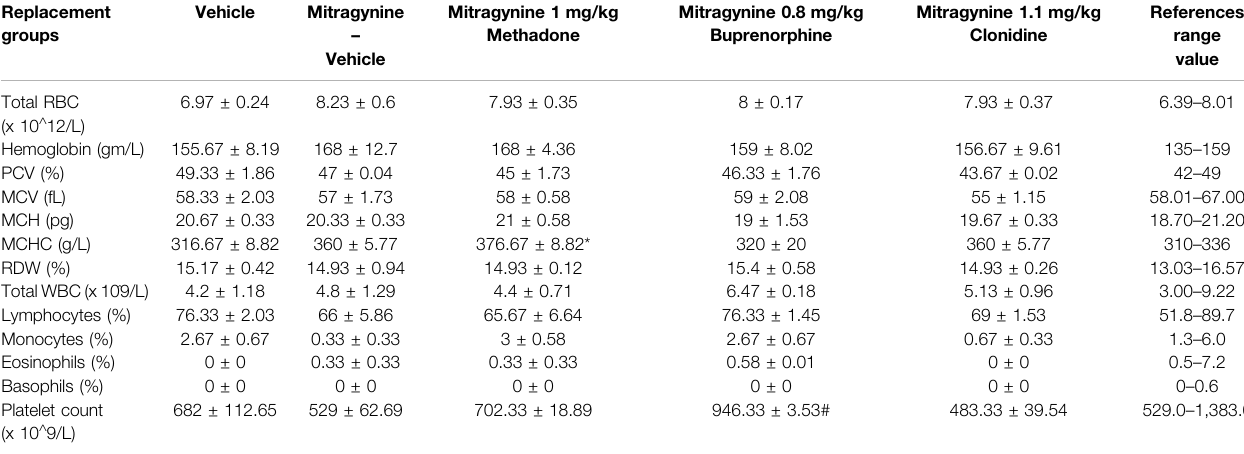
TABLE 2 | Hematological analysis on day 5 in mitragynine replacement treatments. Replacement groups